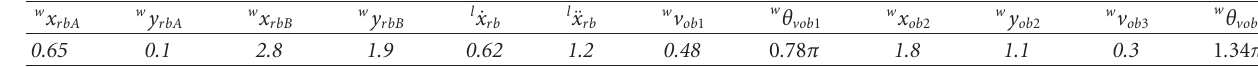
Table 3: Multiple obstacle-avoidance simulation